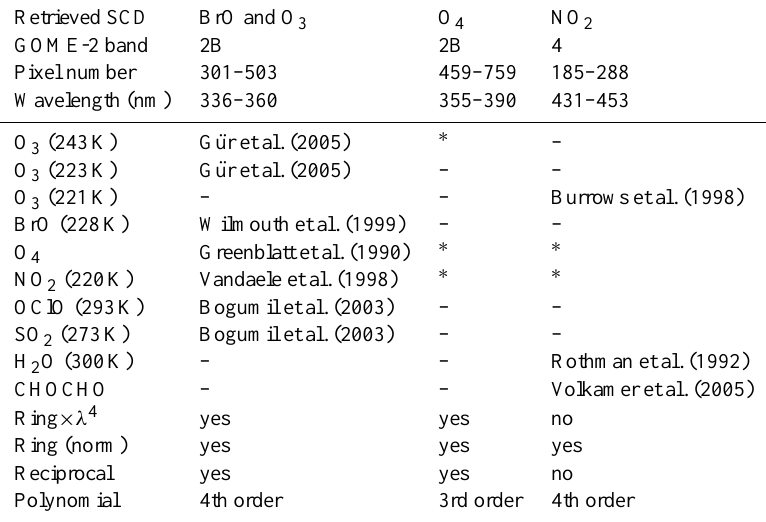
Table 1. Compilation of fit ranges, reference cross-sections and parameters of the three DOAS evaluations of calibrated radiance spectra measured by GOME-2. The slant column densities (SCDs) of BrO, O 3 , O 4 and NO 2 are retrieved. The synthetic Ring spectra account for (wavelength-dependent) inelastic Raman scattering, and the reciprocal intensity spectrum accounts for instrumental stray light (see text). The fit-polynomial models broadband